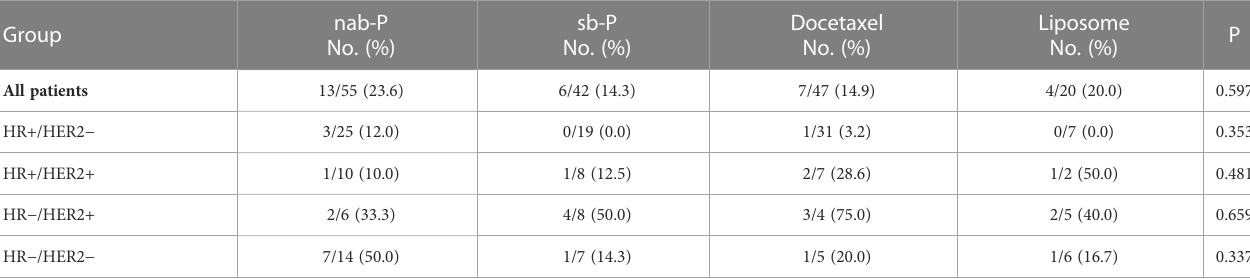
TABLE 5 pCR rates were similar among different